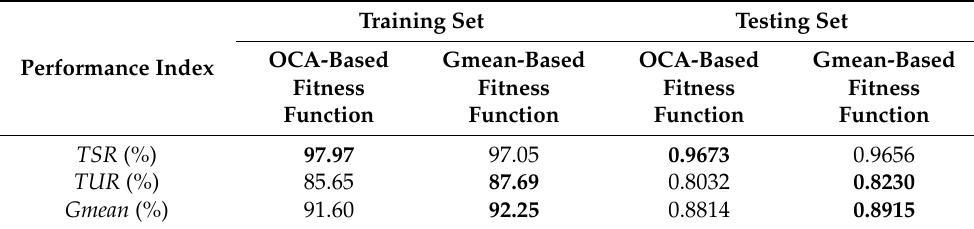
Table 7. Comparison of the average results of different fitness functions.